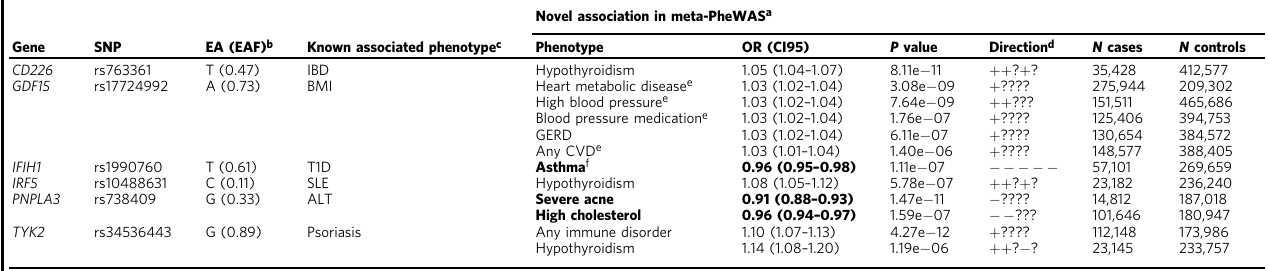
Table 3 Signi fi cant novel associations in the PheWAS meta-analysis